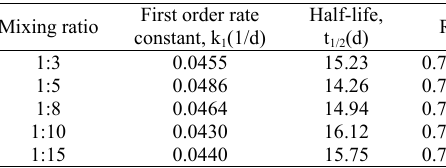
Fig. 6: Trend of (a) the TKN, (b) TP, (c) C: N and (d) C:P changes during the IVC process